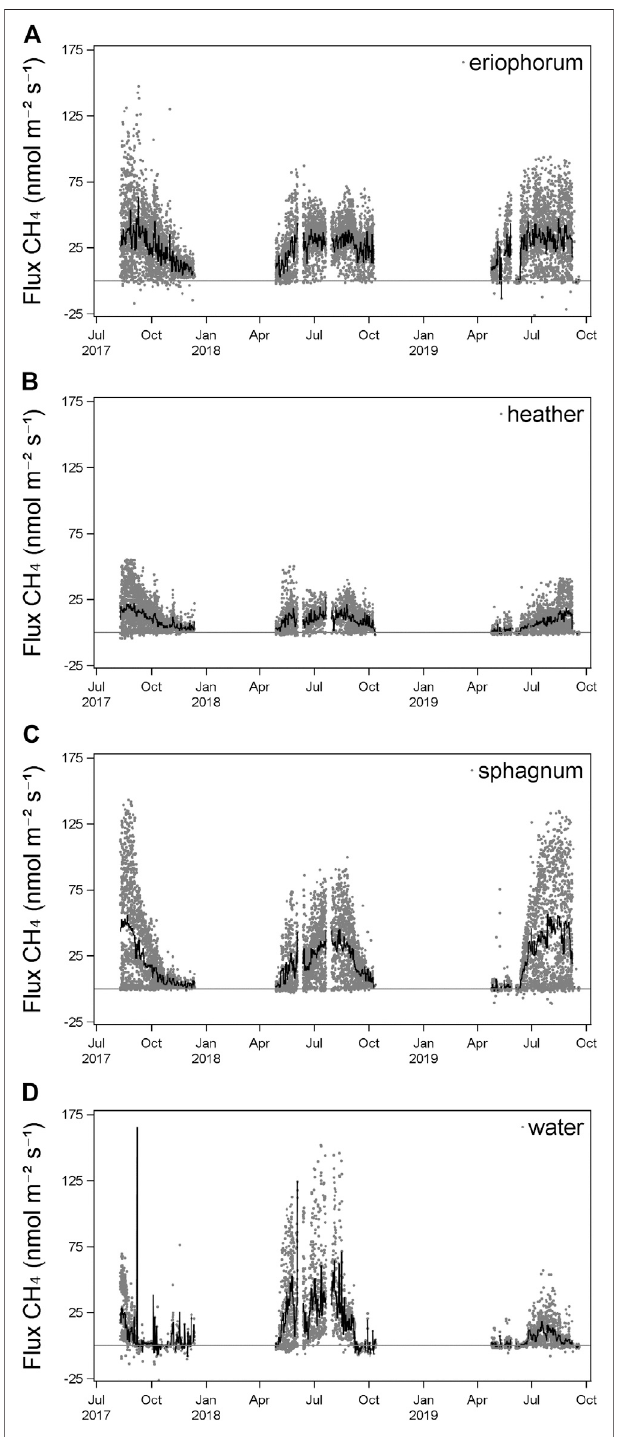
FIGURE 3 | Individual chamber measurements of CH 4 (gray points) and daily mean (n (cid:2) 6, black line) of each ecotype.